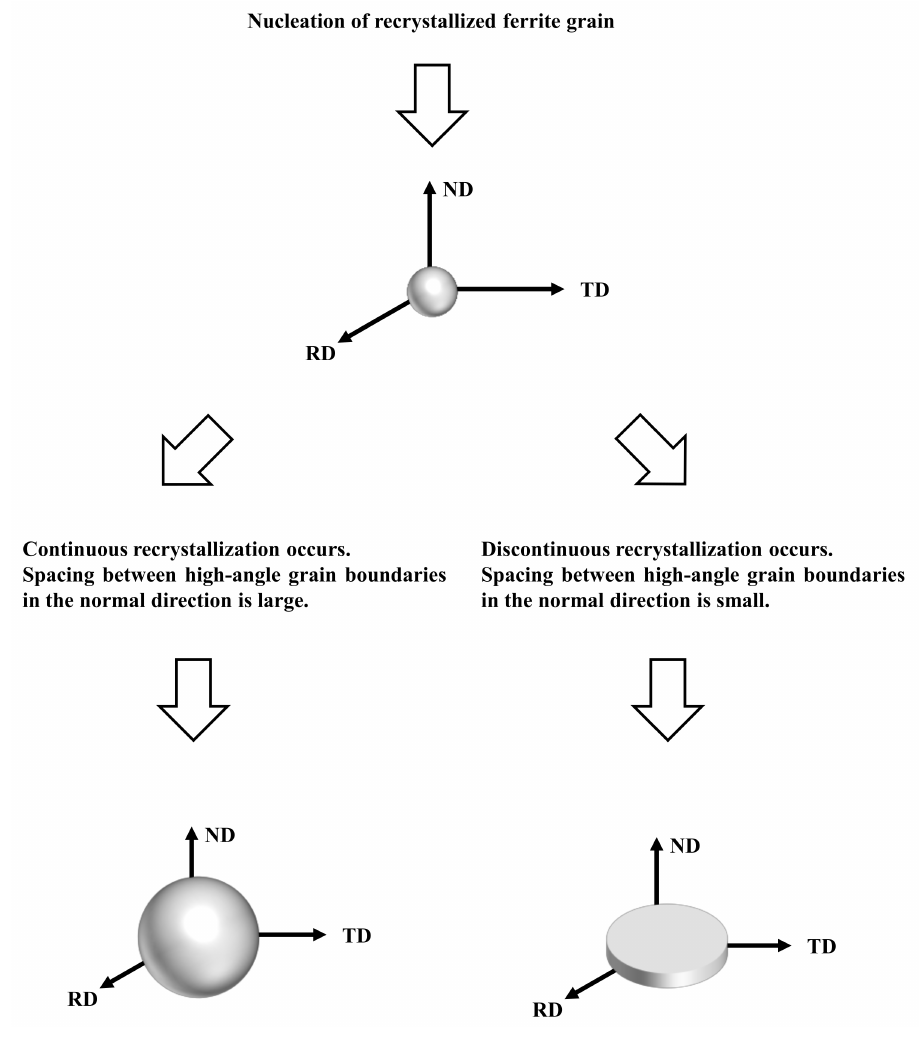
Figure 10. Schematics of 3D microstructural evolution during ferrite recrystallization. Three-dimensional morphology of various ferrite, such as Widmanstätten [27], acicu- lar [28,29], allotriomorphic [30,31], and degenerate ferrite [32], were investigated, whereas that of simple polygonal ferrite has not been reported. Herein, we propose a model of